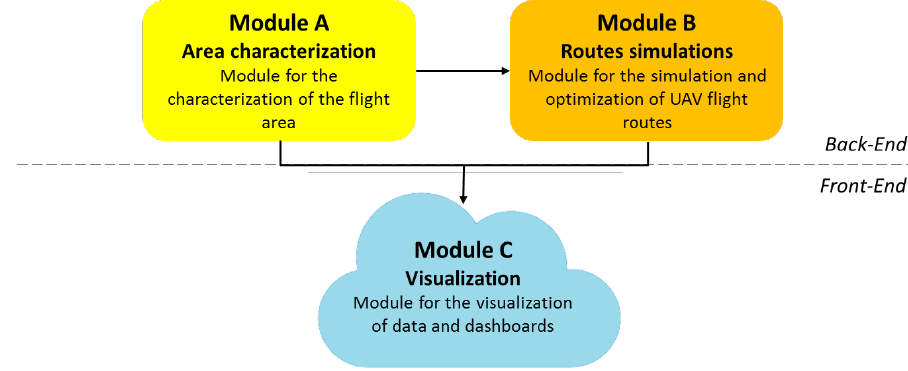
Figure 2. FLIP functional architecture.